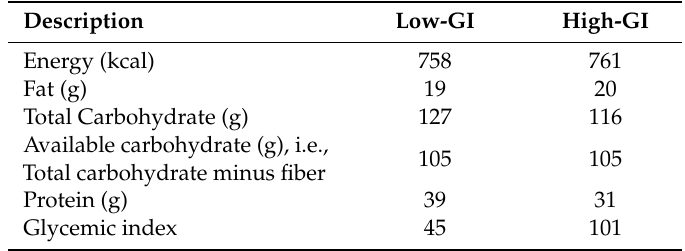
Table 1. Characteristics of the sport nutrition bars for a 70 kg participant.